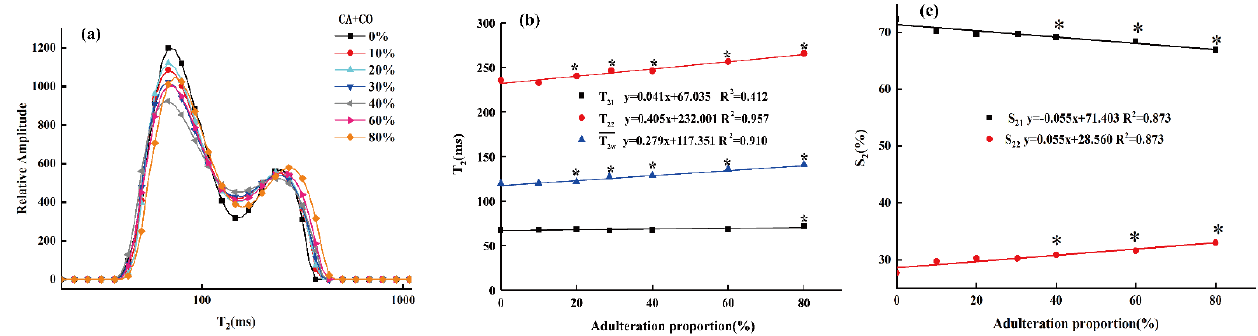
Figure 4. T 2 distribution of camellia oil (CA) adulterated with various proportions of corn oil (CO) ( a ); LF-NMR parameter changes of camellia oil (CA) samples adulterated with different adulteration ratios of corn oil (CO). The transverse parameters of the single component’s (weighted average) relaxation time 𝑇 2𝑤 ̅̅̅̅̅ , the multi-component transverse relaxation times T 21 and T 22 ( b ), and the peak area proportions S 21 and S 22 ( c ). * represents a significant difference ( p < 0.05) between the pure camellia oil (CA) and the samples at specific adulteration ratios.